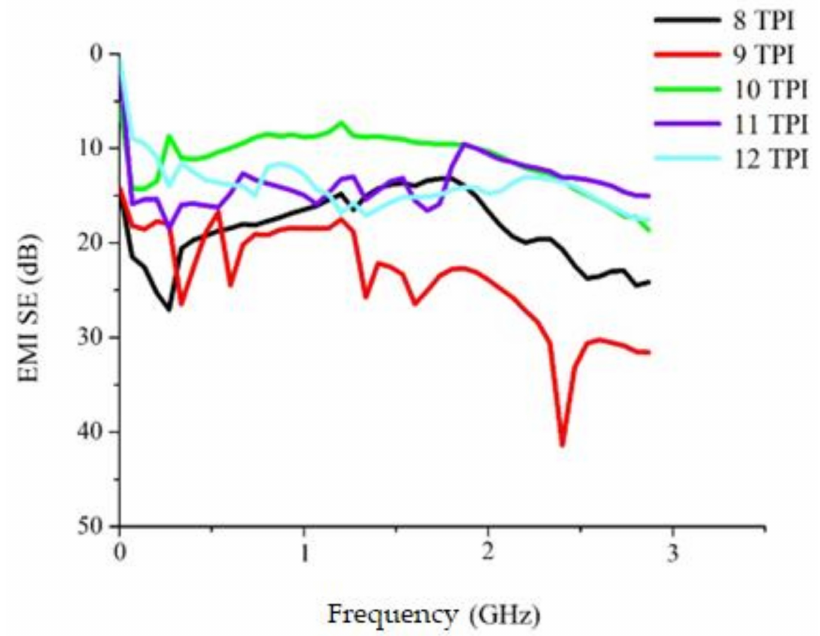
Figure 8. Electromagnetic wave shielding of non-woven fabrics composed of Ge/SS core-spun